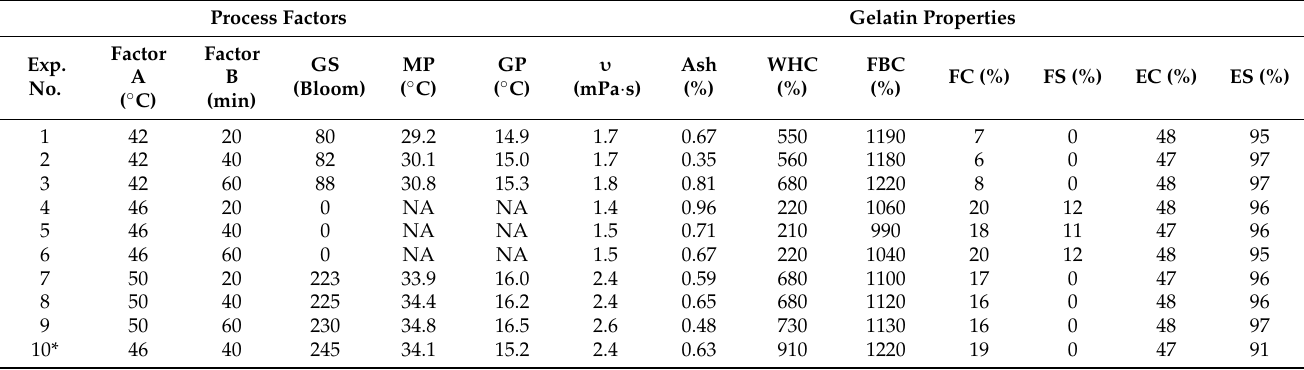
Table 6. Results of the analysis of the properties of the third gelatin